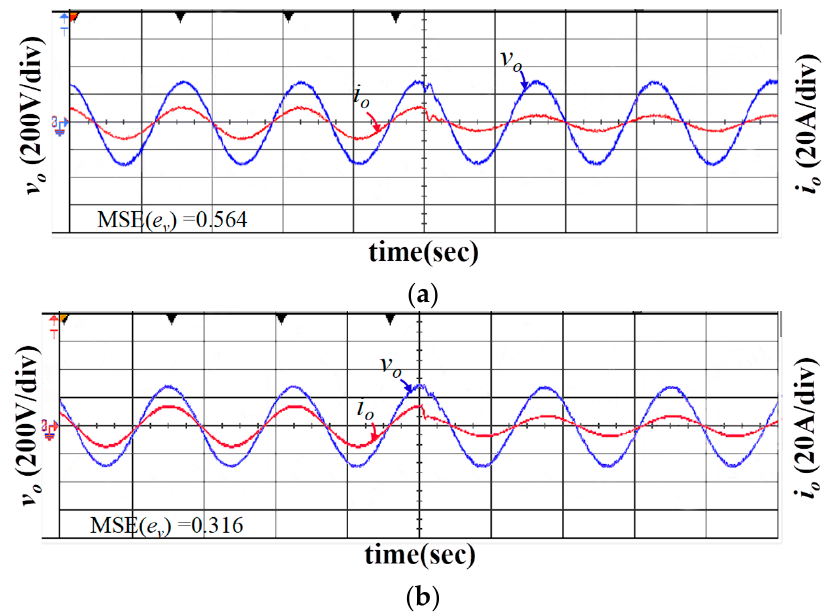
Figure 12. Experimental results under load disturbance: ( a ) SMC; ( b ) proposed AFSMC.